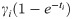
Networks with k = 4 nodes in the reticulation cycle and identical unrooted topologies.They differ in their hybrid position (left: good diamond, right: bad diamond I). If D2 is not sampled (n = 4), only γi(1-e-ti) for i = 1, 2 are identifiable and the 2 networks are not distinguishable from each other.